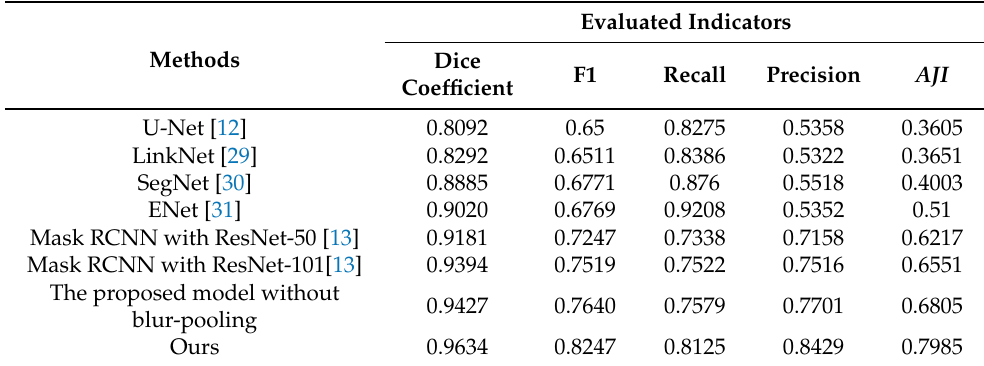
Table 2. Quantitative comparison of different methods applied to MoNuSeg